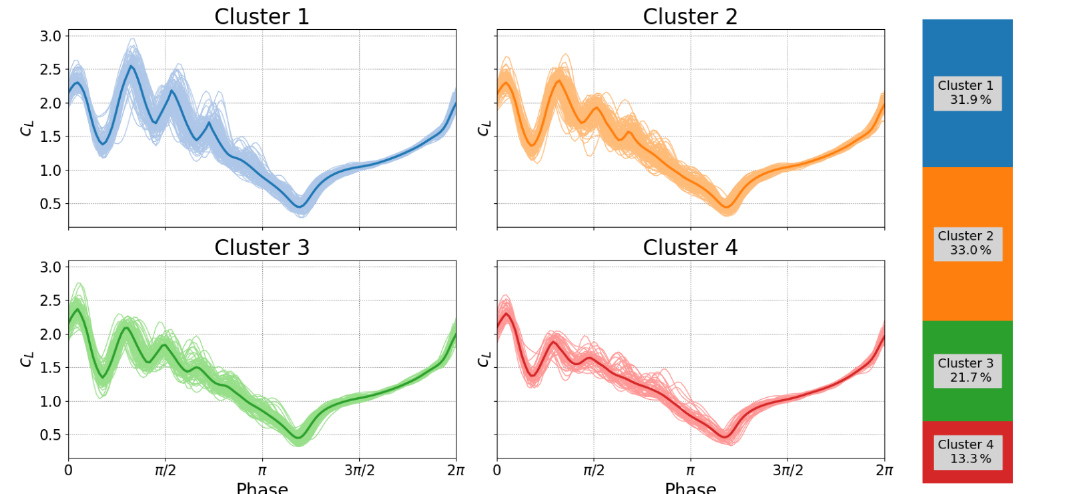
Figure 15. Deep stall investigations: cluster analysis for boundary conditions: k = 0 . 0992, Re = 3 . 3 × 10 5 and α 0 = 21 . 25 ◦ , α amp = 8 . 25 ◦ .